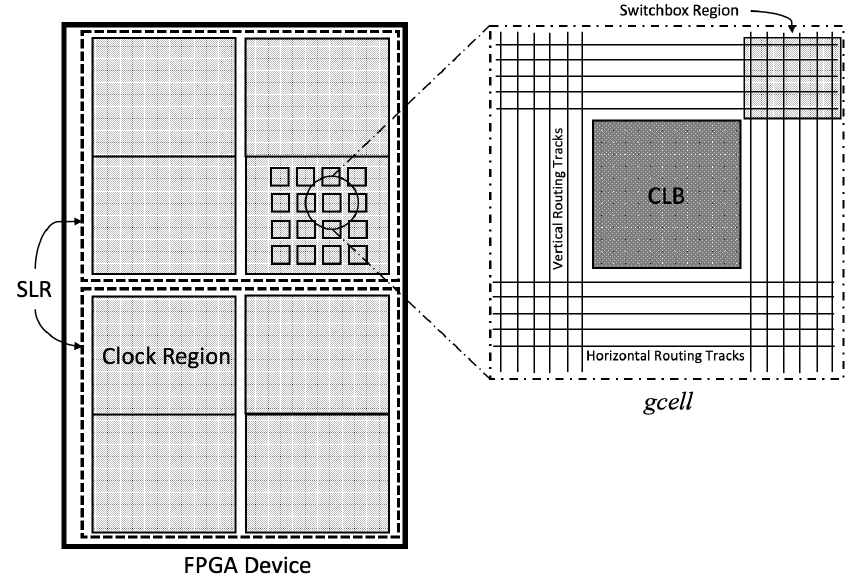
Figure 2. Architecture of Xilinx Ultracale+ FPGAs. The hierarchical architecture has lowest level of granularity at CLB sites. CLB sites are surrounded by horizontal and vertical